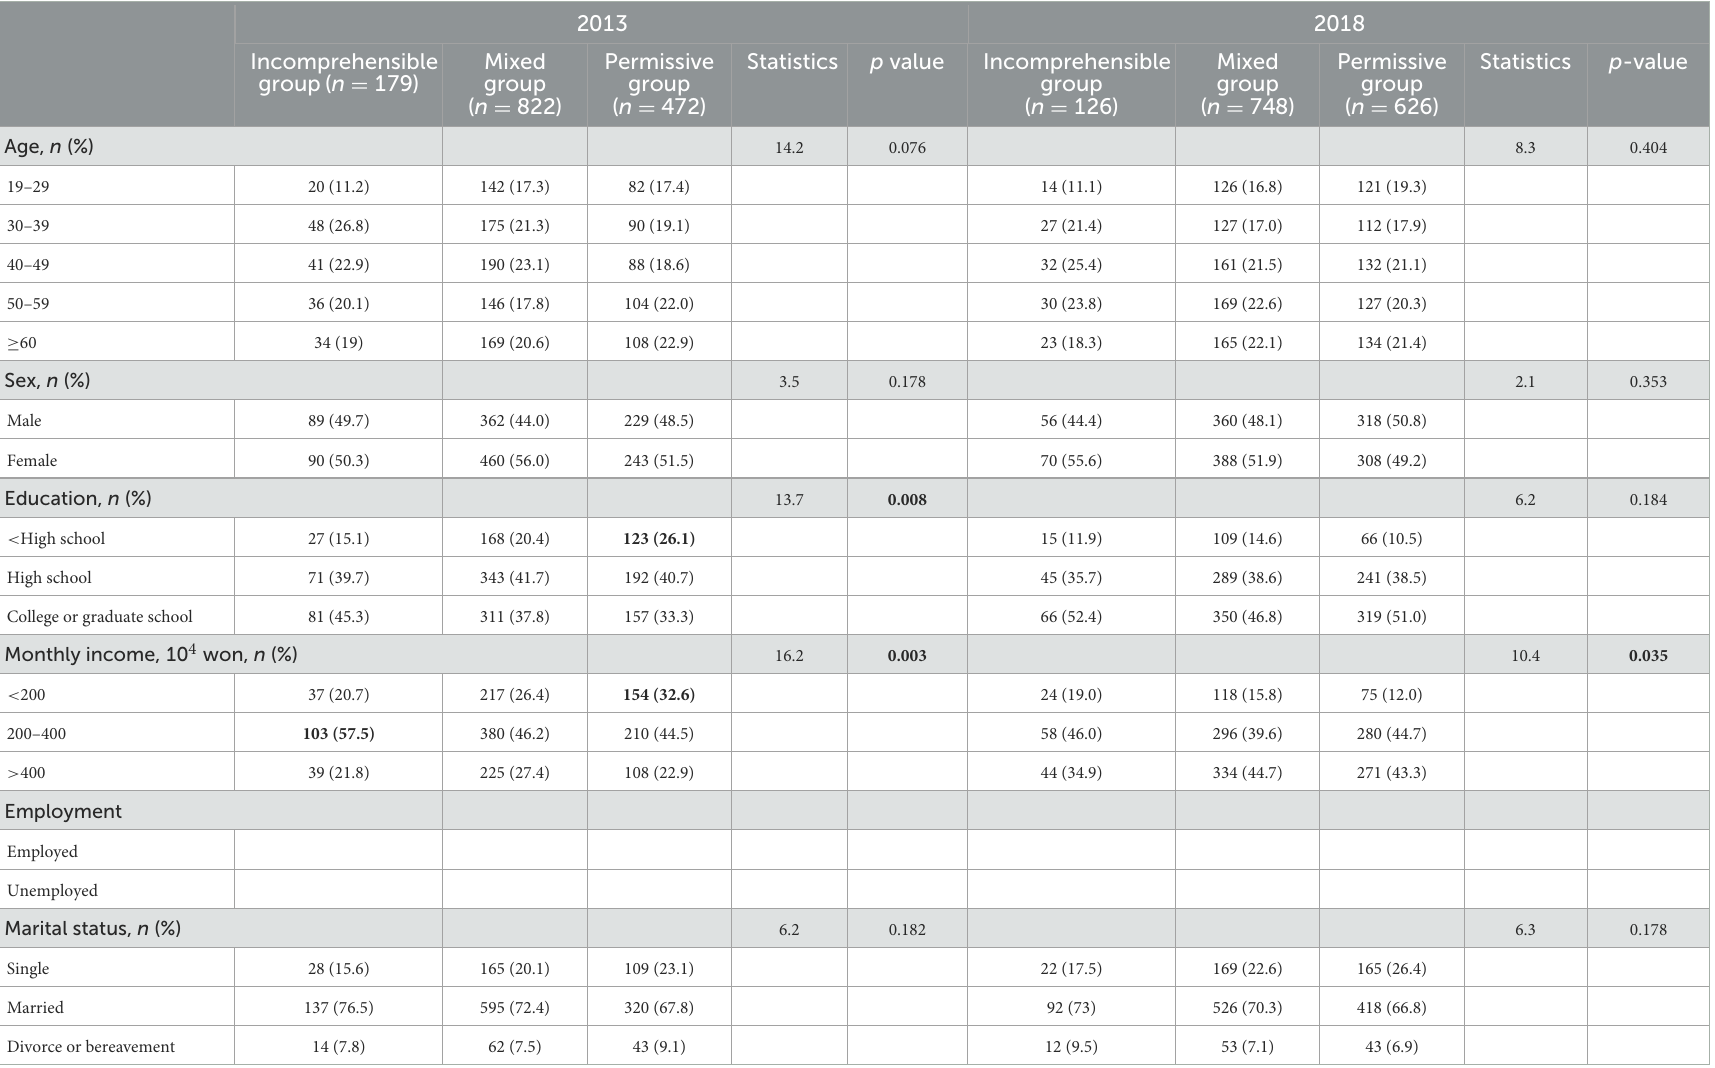
TABLE 4 Comparison of sociodemographic characteristics between the three classes by survey